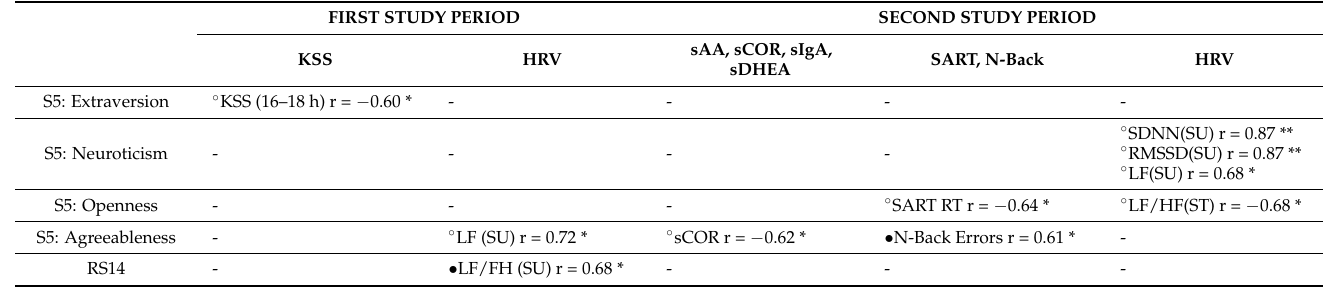
Table 5. Statistically significant correlations regarding psychological